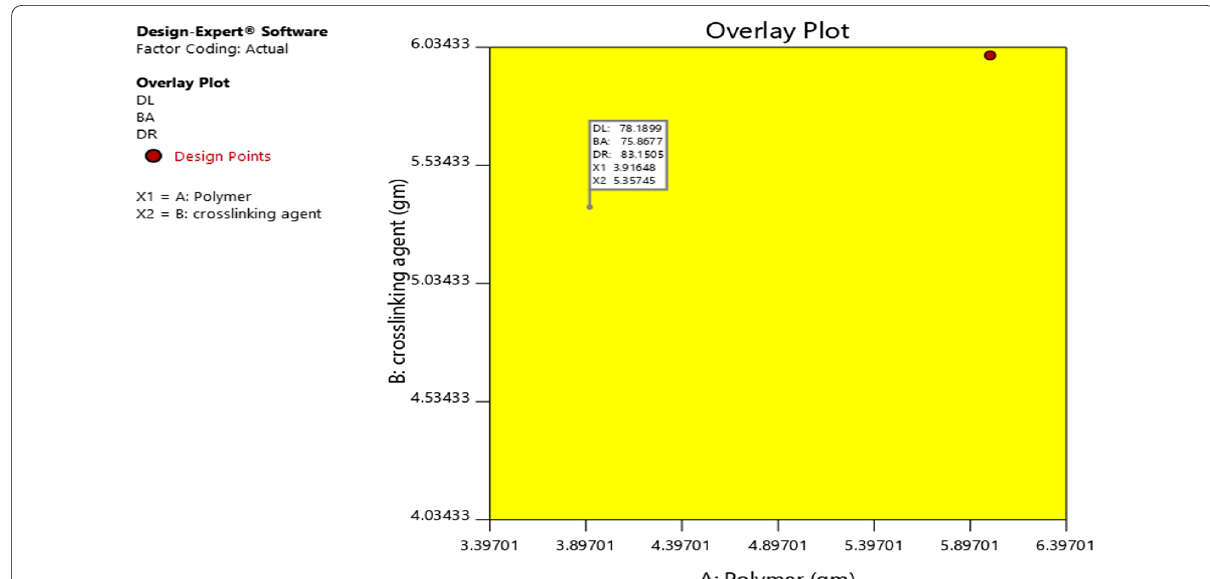
Fig. 11 The overlay plot of the desirability function generated by the software that provided the details of the optimized batch giving the desired optimum results required in our study purpose